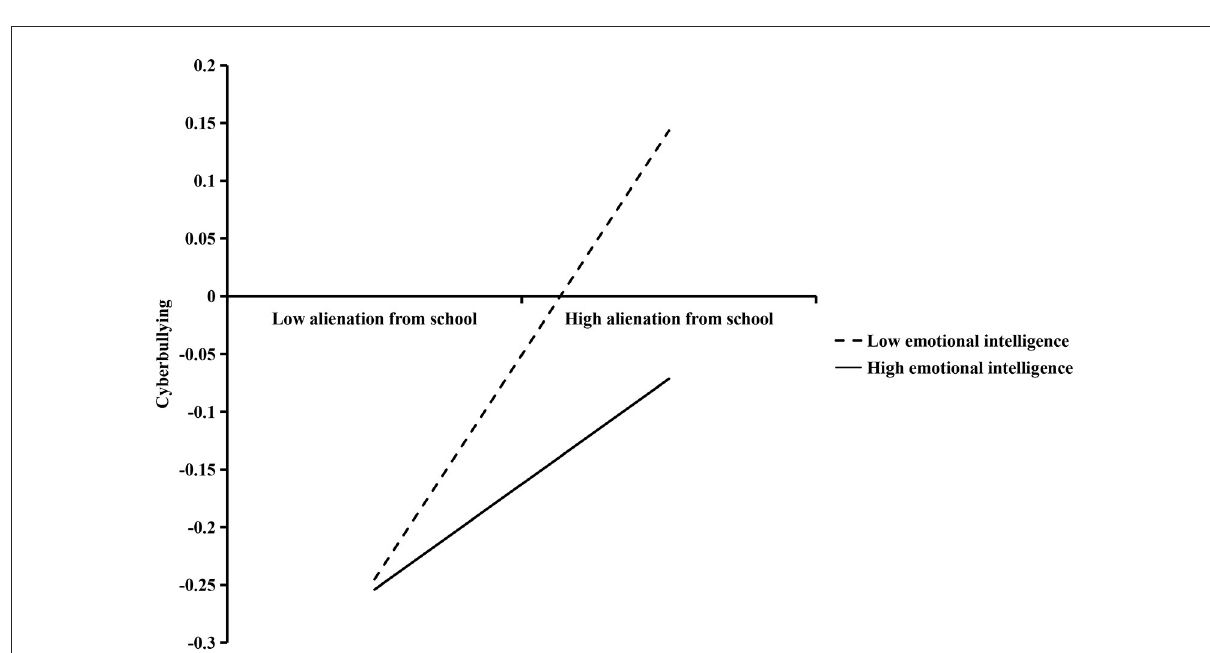
FIGURE4 The moderating role of emotional intelligence in the effect of alienation from school on